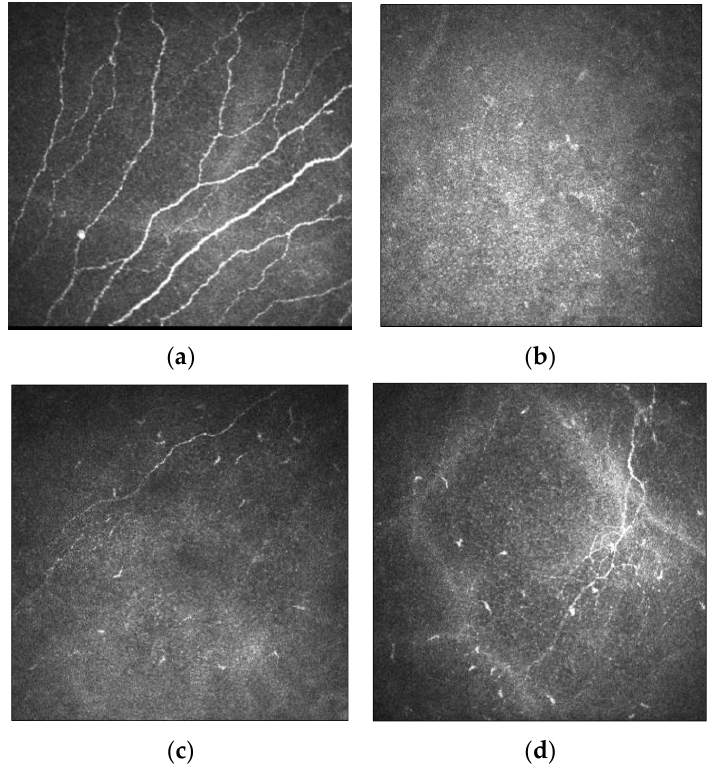
Figure 5. IVCM images demonstrating corneal nerve architecture before and after CXL. ( a ) Thickened subbasal nerves as noticed in a keratoconic cornea before CXL. ( b ) There is decreased nerve fibre density 1-month post-CXL. ( c ) At 4-months after CXL, there is an initial re-innervation process characterized by sprouting nerve fibres. Langerhans cells are also detectable, suggestive of transient post-CXL inflammation. ( d ) Increased nerve fibre density and tortuosity 1-year after CXL. Scale bar: 100 µm.